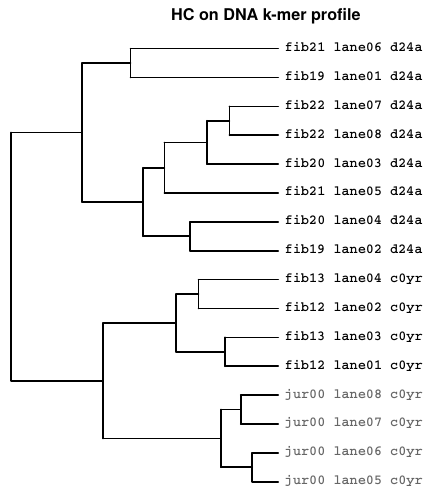
Figure 4. Batch effect indicated by HcKmer on samples sequenced in two Illumina Flowcells: Leaf labels denote cell type (fib = Fibroblasts, jur = Jurkat cells) and number of individual, lane number and Flowcell label ( d24a and c0yr ). Samples from Jurkat cells are highlighted in grey. The tree clearly separates Flowcell d24a and c0yr although Flowcell c0yr contains two different cell types. Figure 5, indicates that median Phred scores in sequences from both Flowcells are sufficiently high (see also Section 1.4).